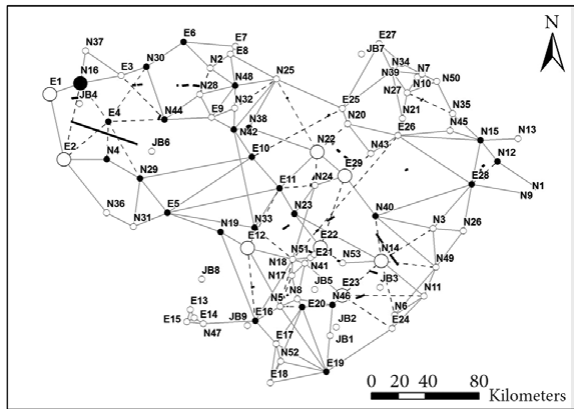
Fig. 6. Reshuffle of core areas and their impact to overall connectivity of ecological